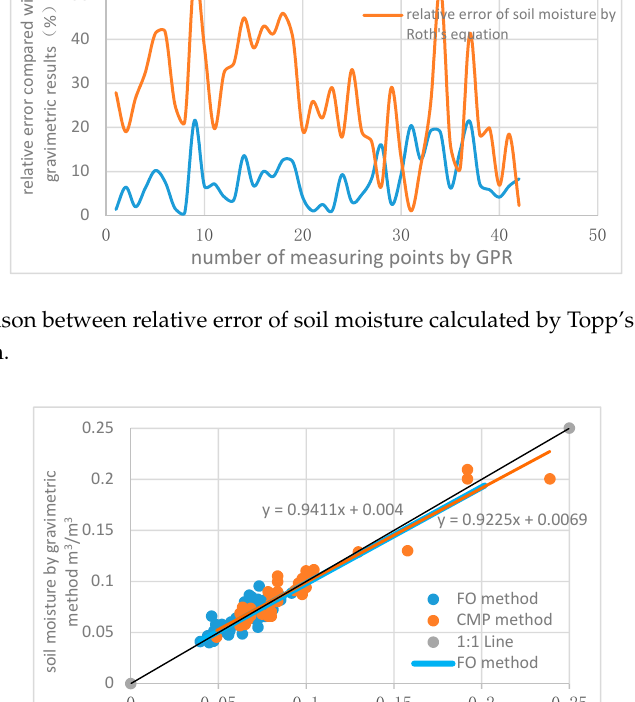
Figure 6. Soil moisture calculated by CMP method and FO method in comparison with gravimetric method.